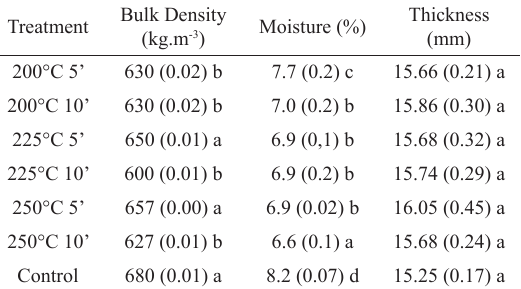
Table 2: Average values of bulk density, moisture and thickness of the MDF panels. Bulk Density Treatment (kg.m -3 )